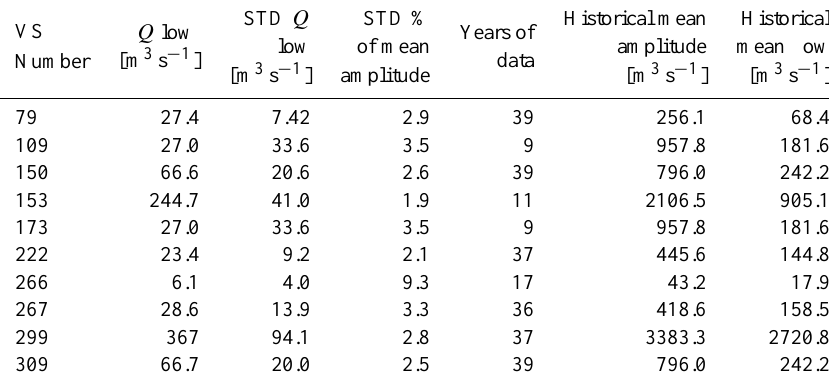
Table 4. In situ average low monthly flow values and standard deviations.